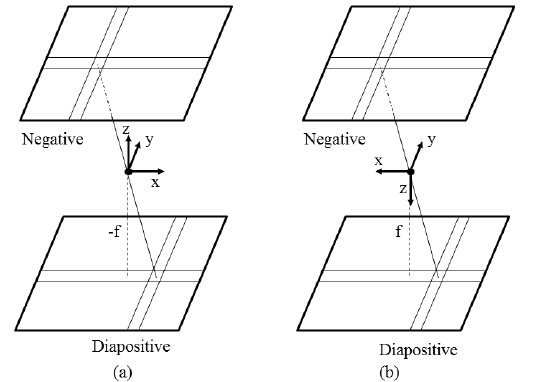
Figure 3 – Photogrammetric reference system: (a) Perspective and equi-distant projections; (b) Stereo-graphic, equi-solid- angle and orthogonal projections.